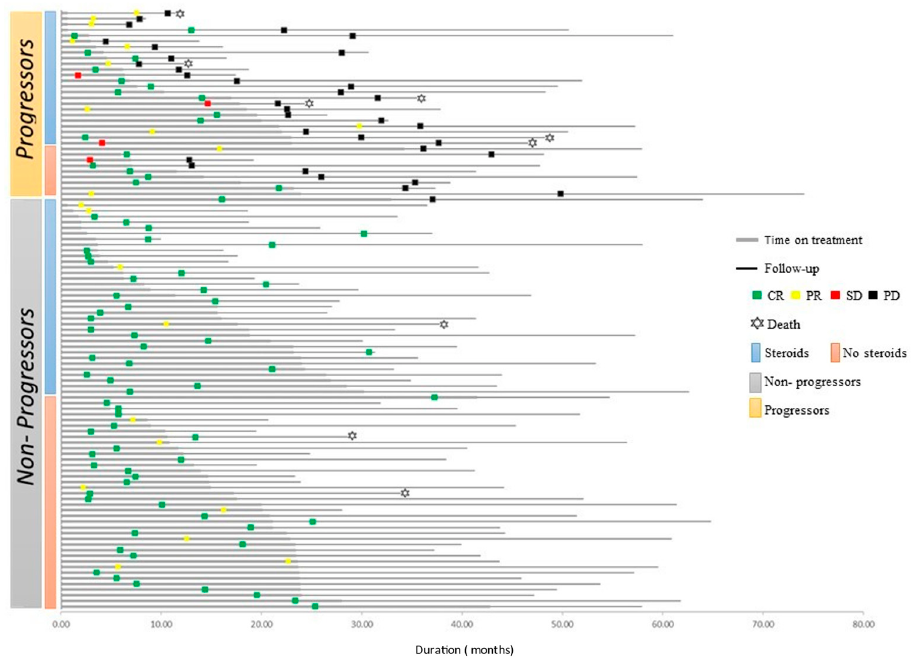
Figure 7. Individual clinical courses of all patients treated with immunotherapy who discontinued treatment in the absence of disease progression. Data is presented from treatment initiation to the last follow-up or death. Patients were sorted according to disease progression and steroid exposure. Patients achieving CR were less likely to have disease progression at treatment discontinuation (24%), compared to patients achieving PR or SD as best response (50% and 100%,